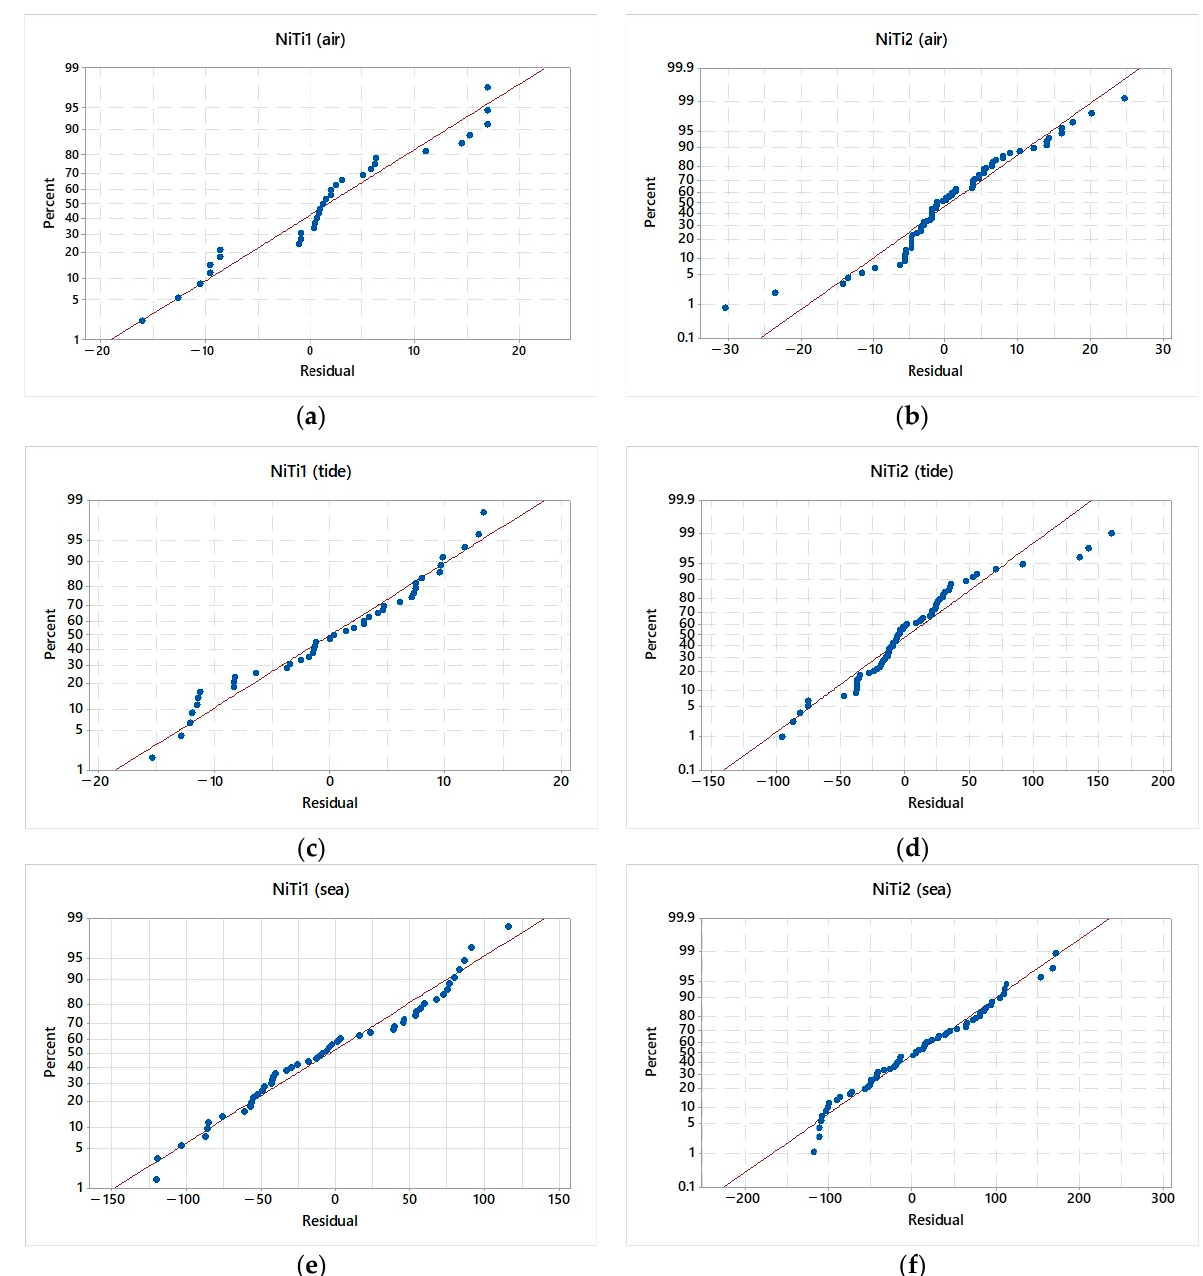
Figure 6. A normal probability plot of residuals for corrosion depth influenced by air on NiTi1 ( a ) and NiTi2 alloys ( b ), influenced by the tide on NiTi1 ( c ) and NiTi2 alloys ( d ), influenced by sea on NiTi1 ( e ) and NiTi2 alloys ( f ).